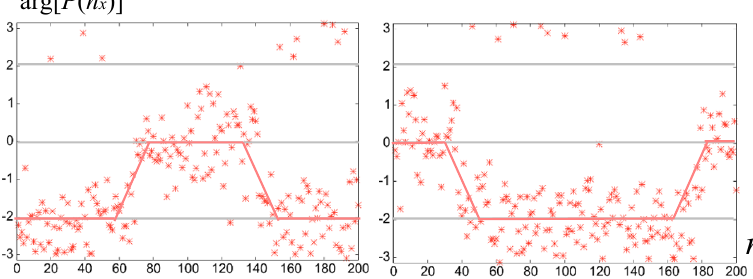
Figure 5 . (Left)(Right): the position dependences of arg[ P ( n x )] on 1 (cid:20) n x (cid:20) N s for the two se- lected con(cid:12)gurations (A) and (B) in the distribution plot for N = 3, (cid:12) = 3 : 0 with ( N s ; N (cid:28) ) = (200 ; 8) for the Z 3 -TBC. We show the three vacua by gray lines and the speculated vacuum transitions by red lines. Both correspond to bion